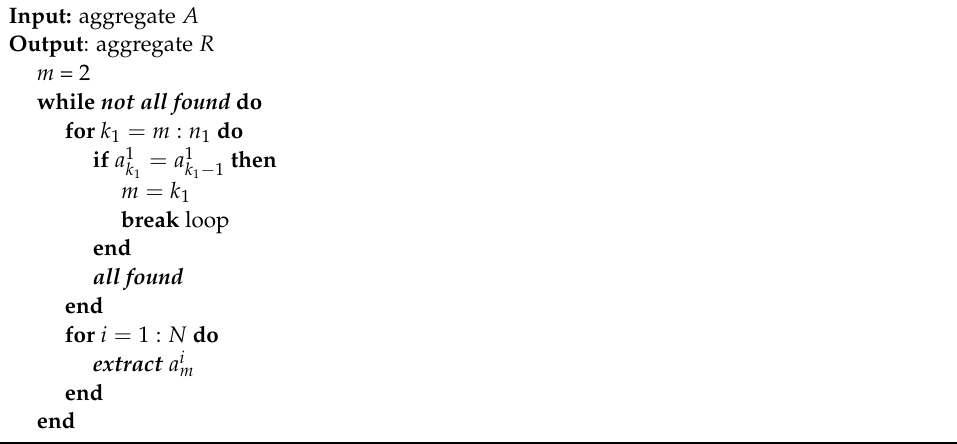
Figure 3. An example of two incompatible aggregates.